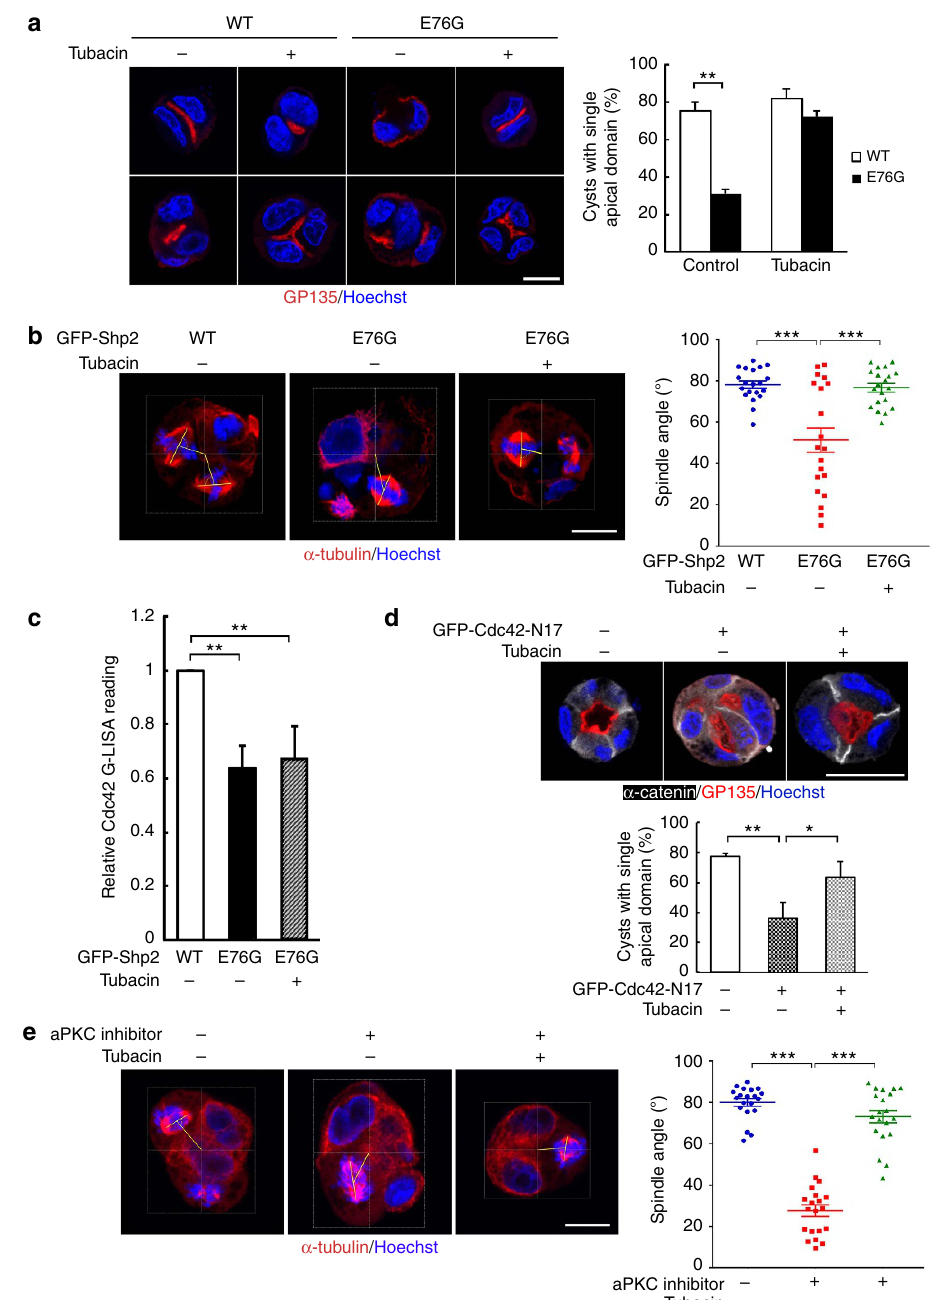
Figure 5 | HDAC6 inhibition allows normal apical domain formation independent of Cdc42 signal. ( a , b ) MDCK expressing GFP-Shp2-WTor GFP-Shp2- E76G were embedded in Matrigel and treated with or without 1 m M of tubacin for 24h. ( a ) Cyst were extracted for IF staining analysis, and the percentage of cysts with single apical domain is shown in the right (514–637 cysts were counted in each experiment, n ¼ 3.) ( b ) Cyst cultures were further treated with 10 m M of RO-3306 for 16h to synchronize cells at the G2/M phase, and then released by replacement with normal medium for 40–50min. Cysts were extracted for spindle analysis by a -tubulin IF and Hoechst staining. The angle between the spindle axis (thick line) and the thin line connecting the centre of cyst and the midpoint of spindle axis was measured. Scatter diagram of metaphase spindle angles are shown on the right. The data are presented as mean ± s.e.m.; ( n ¼ 20). ( c ) MDCK cells stably expressing GFP-Shp2-WTor E76G mutant were treated with tubacin (1 m M) for 2 days and harvested for Cdc42 activity by G-LISA assay. ( d ) GFP or GFP-Cdc42-N17-expressing MDCK cells in Matrigel and treated with tubacin (1 m M) for 2 days. Cysts were fixed and IF stained with antibodies as indicated. The percentage of cysts with single lumen is shown at the bottom (100 green-positive cysts were counted in each experiment, n ¼ 3). Values are mean ± s.d. from three independent experiments.* P o 0.05, ** P o 0.01 based on two-tailed unpaired Student’s t -test. ( e ) MDCK cells in Matrigel were treated with 20 m M of aPKC inhibitor with or without tubacin (1 m M) for 24h, followed by synchronization with RO-3306 for spindle observation. Right panel shows the spindle angle and data were presented as ( b ). *** P o 0.001 based on two-tailed Student’s t -test. Scale bars, 10 m